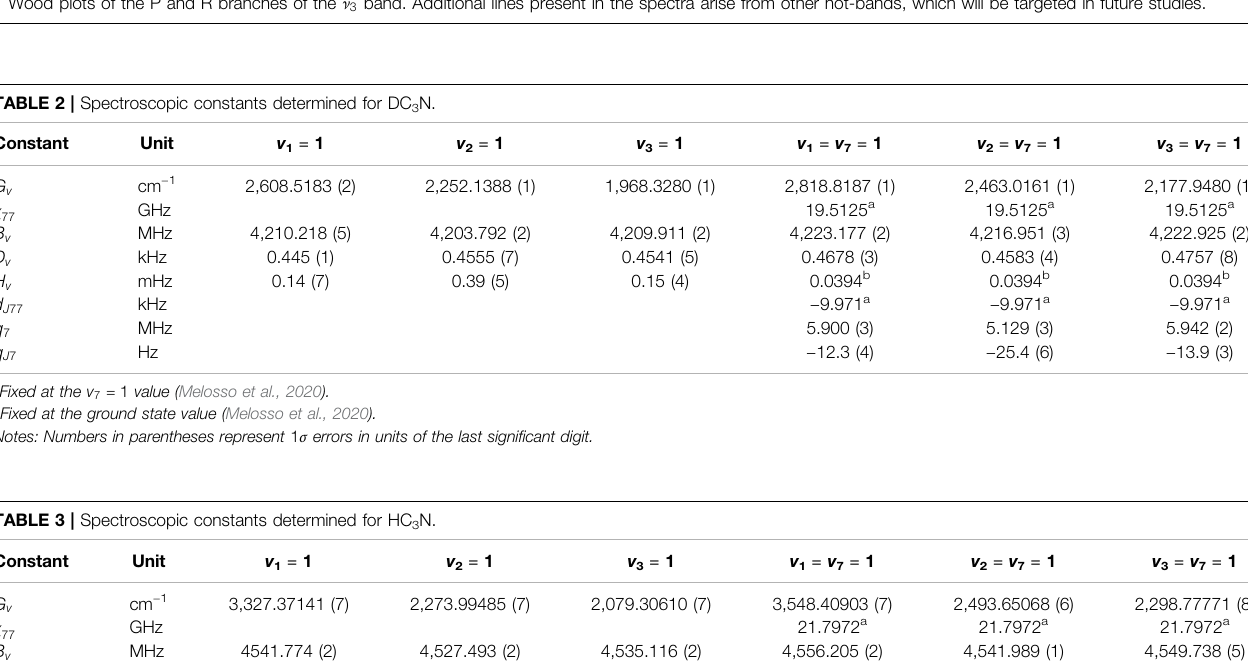
FIGURE 3 | (Left panel) : Portions of the DC 3 N spectrum in the region of the ] 3 band system. Recording conditions: same as Figure 2 . (Right panel) : Loomis- Wood plots of the P and R branches of the ] 3 band. Additional lines present in the spectra arise from other hot-bands, which will be targeted in future studies.